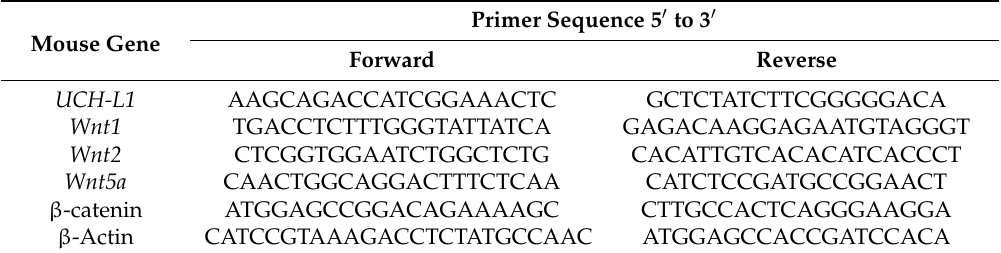
Table 1. Nucleotide sequences of the primers used for RT-PCR in this study. Primer Sequence 5 (cid:48) to 3 Mouse Gene